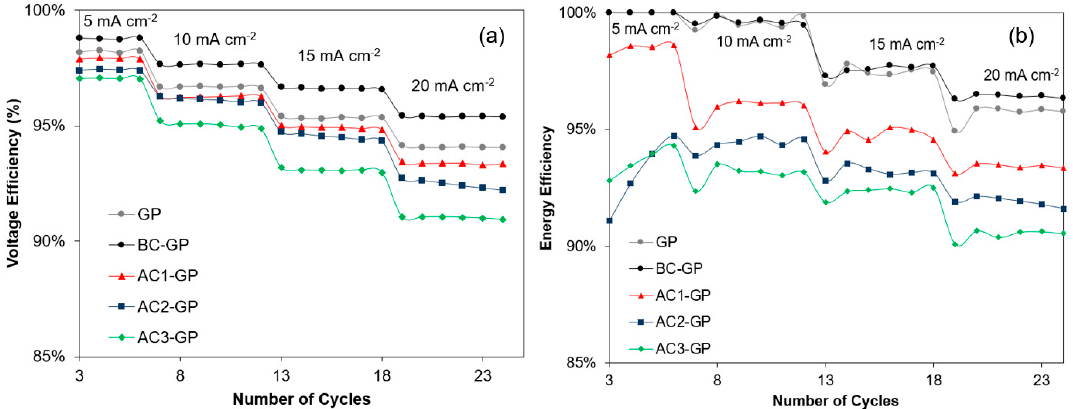
Figure 7. Voltage ( a ) and energy ( b ) efficiency over different current densities.